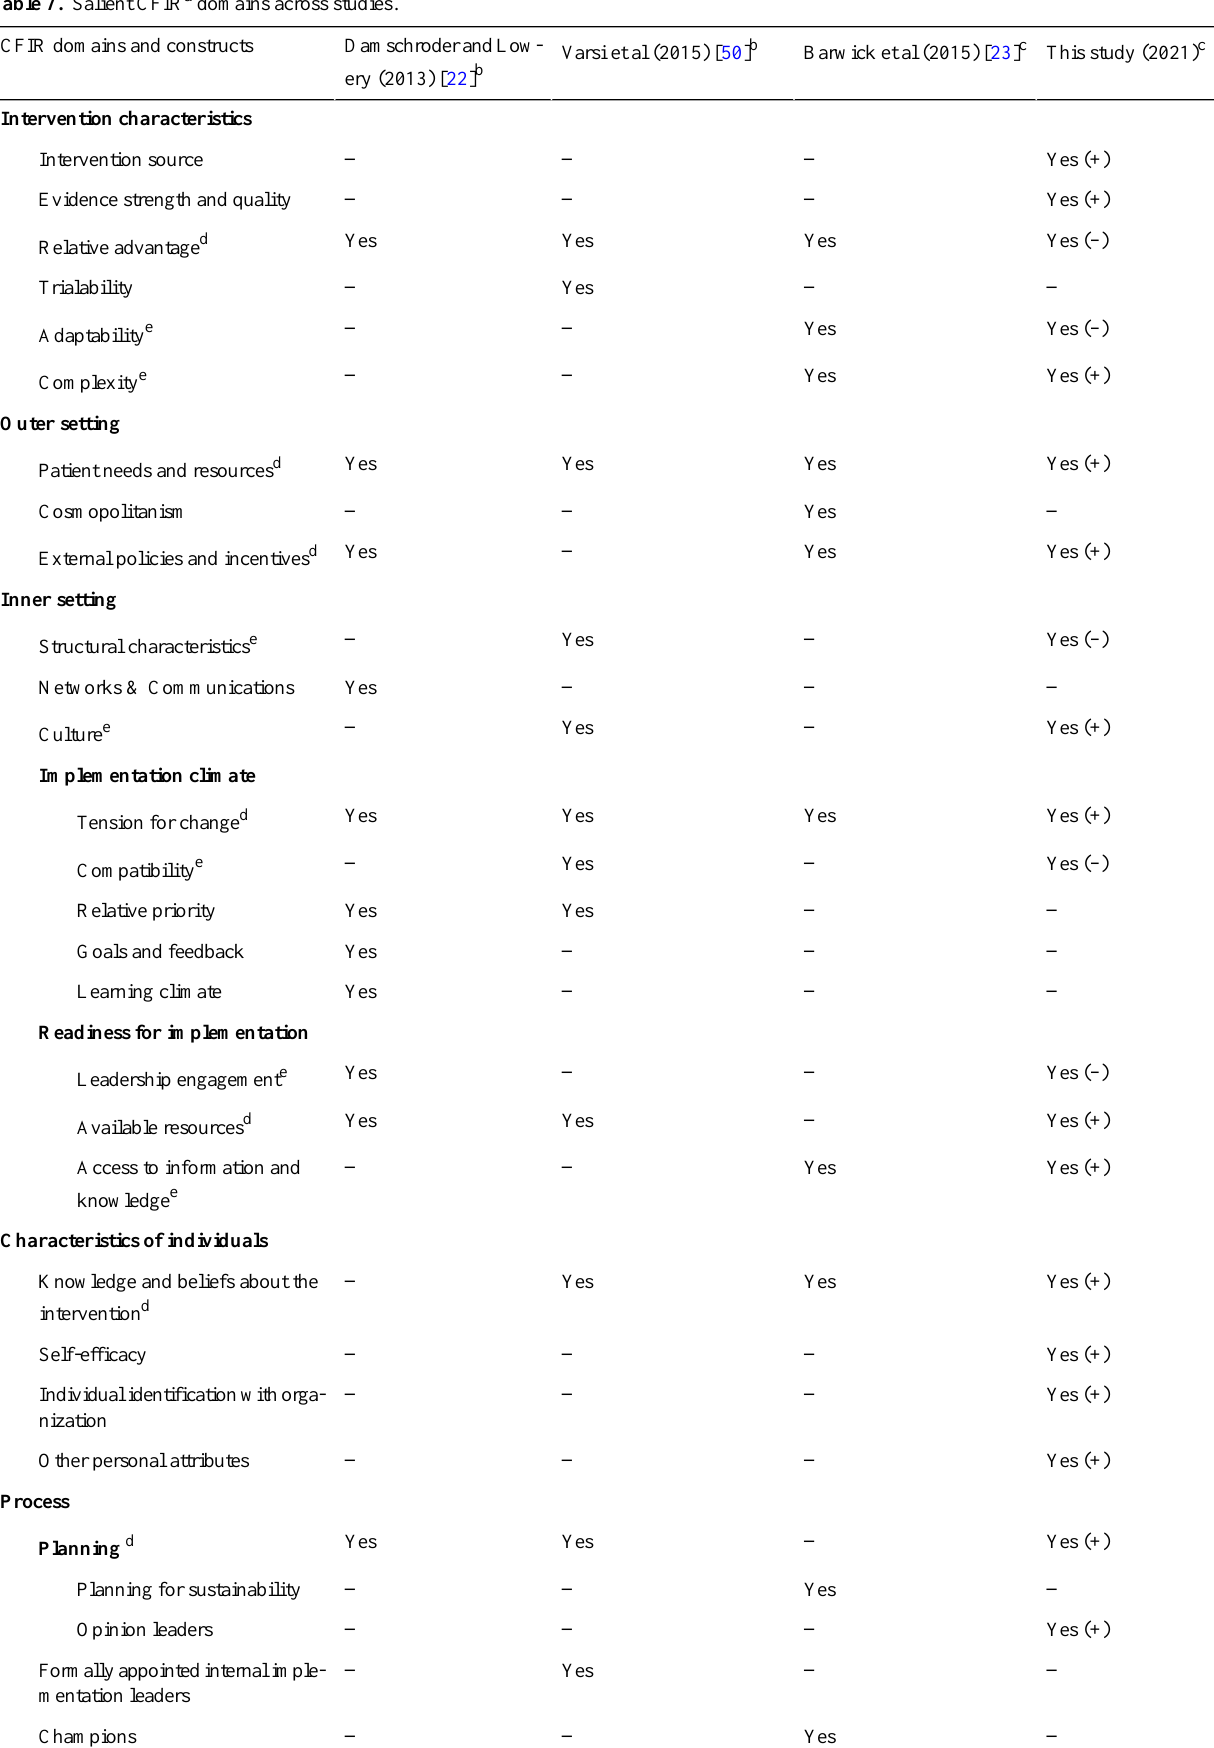
Table 7. Salient CFIR a domains across